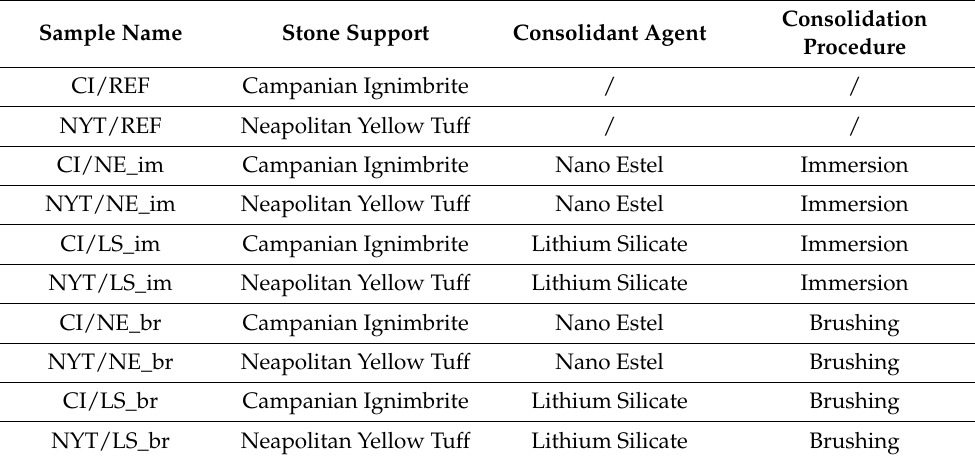
Table 2. Schematic summary of all the different samples